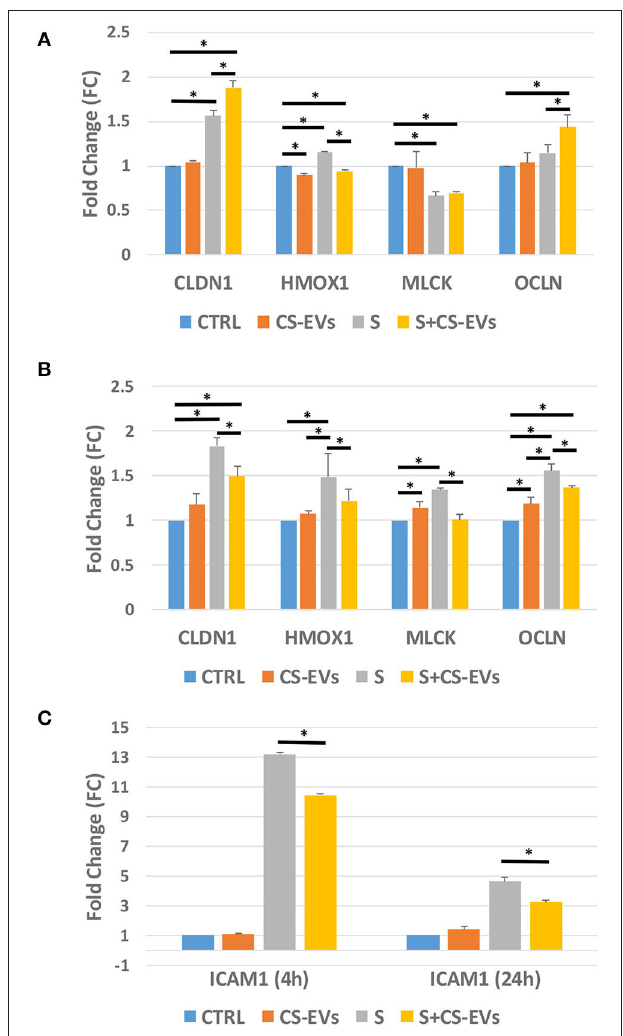
FIGURE 5 | Gene expression of tight junctions and inflammatory genes. Real-time qPCR gene expression analysis of intestinal epithelium genes pretreated (or untreated) with CS-EVs (20 µ g/ml) stimulated with an inflammatory cocktail (TNF- α , IL-1 β , and IFN- γ , 10ng/ml each). (A,B) show the expression of CLDN1, HMOX1, MLCK, and OCLN genes after stimulation for 6 and 24h, respectively. (C) shows the expression of ICAM-1 after stimulation for 6 and 24h. Significant differences have been indicated by an asterisk. (* = p -value <